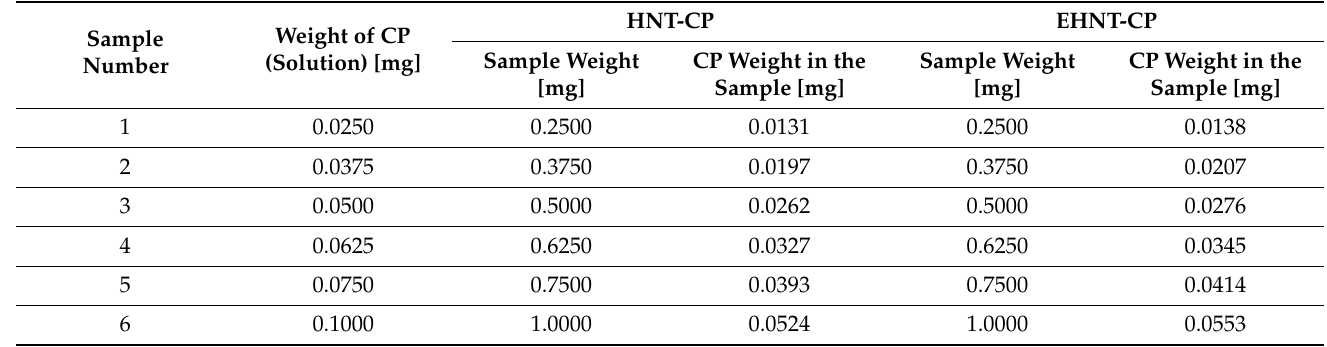
Figure 4. Growth inhibition zones obtained for the Staphylococcus aureus strain grown on the Mueller Hinton II medium after the application of various amounts of: ( a ) CP, ( b ) HNT-CP, ( c ) EHNT-CP (see Table 1). Table 1. The weights of the samples of free CP, HNT-CP and EHNT-CP used in the antibacterial test (see Figure 4) and the calculated content of CP in HNT-CP and EHNT-CP samples.